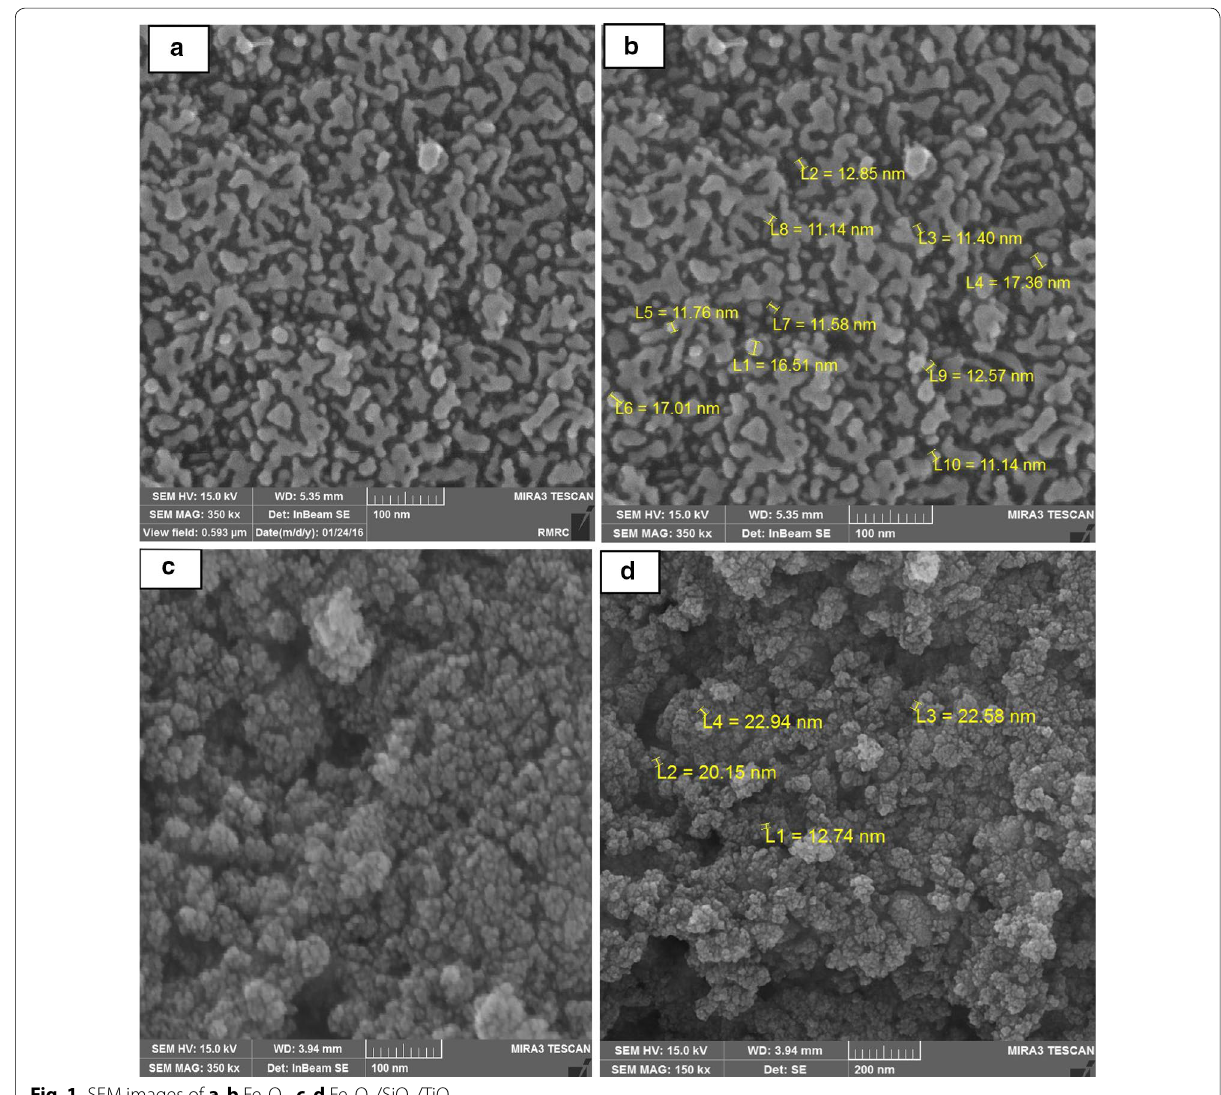
Fig. 1 SEM images of a , b Fe 3 O 4 , c , d Fe 3 O 4 /SiO 2 /TiO